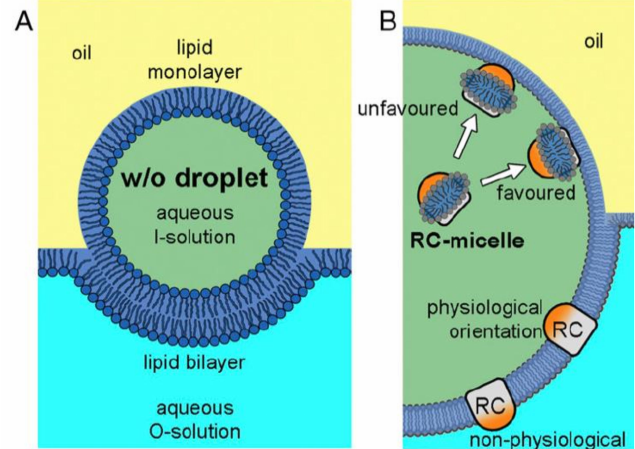
Figure 8. Droplet transfer method for the directed reconstitution of reaction centers (RC) into giant lipid vesicles. ( A ) Water-in-oil (w/o) droplets, which were formed by emulsifying an aqueous solution (I-solution) in an oil phase, were transferred into an aqueous phase (O-solution) by centrifugal forces. ( B ) For the reconstitution of reaction centers (RCs), w/o droplets were formed in the presence of RC-containing micelles. Using this method, a high percentage of correctly oriented RCs in giant lipid vesicles was achieved since the hydrophilic H subunit of the RC (depicted in orange) preferred to face toward to the aqueous core of the droplet. Reprinted with permission from E. Altamura, F. Milano,